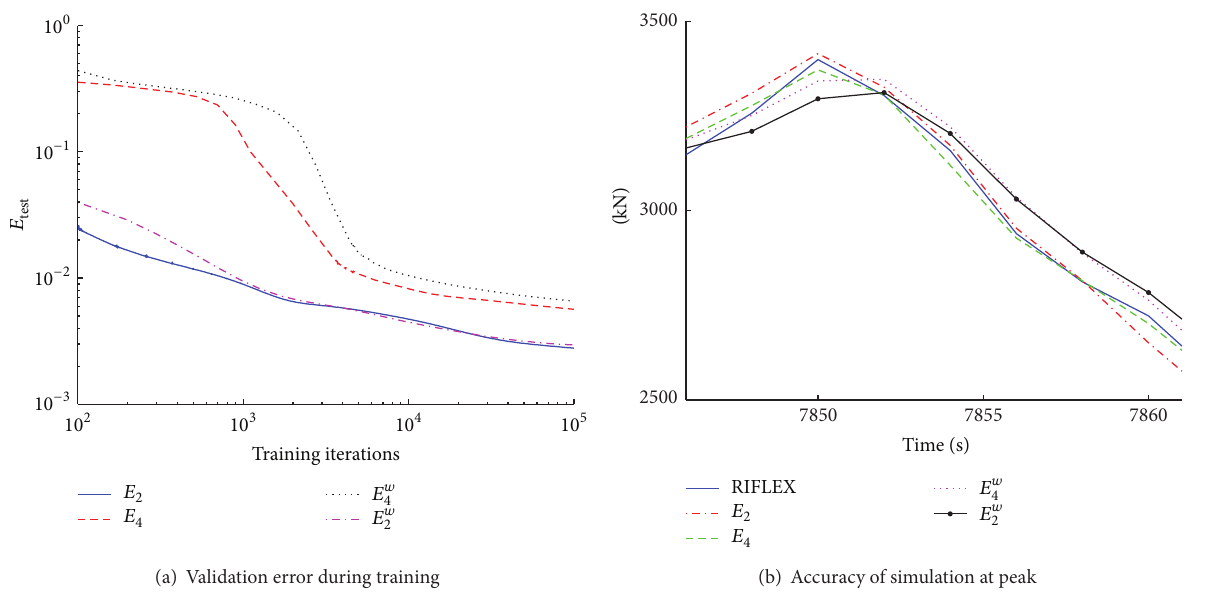
Figure 11: Comparison of performance for the four different error functions.